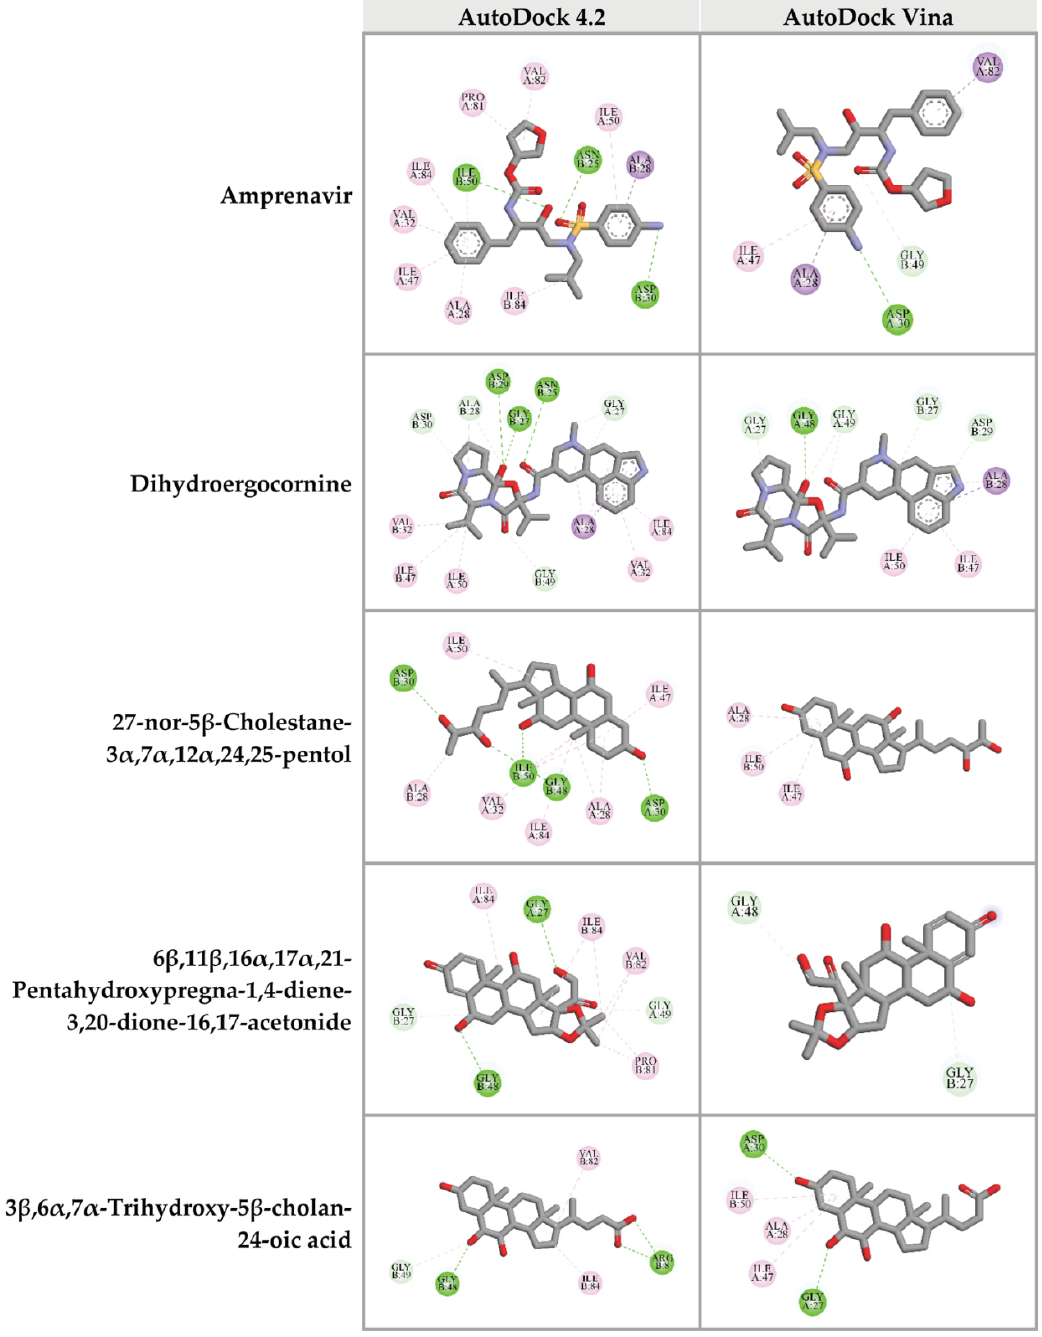
Figure 5. Three-dimensional schematic interaction between HIV-1 PR (PDB: 5KR0) and candidate ligands. Balls and sticks represent amino acid residues and ligands, respectively. Green dashed lines indicate hydrogen bonds. Pink and purple dashed lines indicate hydrophobic bonds.